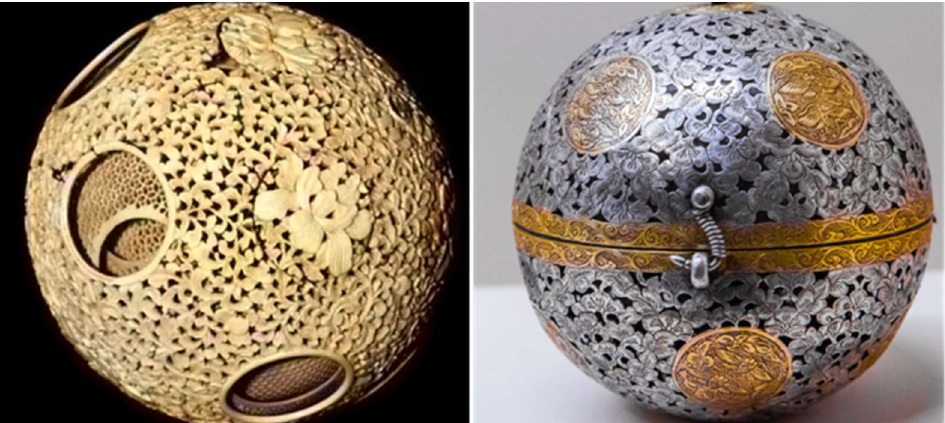
Figure 10. Left: Turned ivory ball imported to Poland from China in the late 18th century. Wilanow Palace Museum, Warsaw, Poland. Right: xiangnang from Famensi. Gilded silver. Diameter: 12.8 cm; weight: 547 g. Tang Dynasty (618–907).